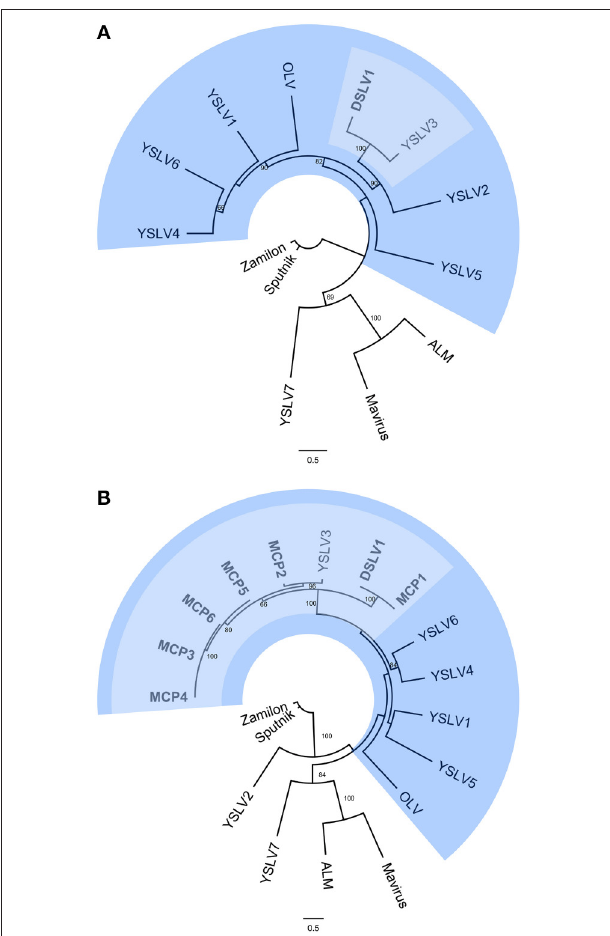
FIGURE 5 | Phylogenetic trees showing the relationship of DSLVs to other virophages. (A) A phylogenetic tree was reconstructed based on amino acid sequences of three conserved genes: MCP, Pro, and ATPase to compare DSLV1 to other known virophages. (B) Phylogenetic analysis of virophage MCP proteins, including all seven DSLV sequences identified in this study. Bootstrap values are indicated on each branch (100 iterations). DSLVs and YSLV3 are shaded in light blue. DSLVs and the closely related YSLVs and OLV are highlighted in blue. DSLVs are shown in bold. YSLV, Yellowstone Lake virophage; DSLV, Dishui Lake virophage; ALM, Ace Lake Mavirus; OLV, Organic Lake virophage. The accession numbers of the DSLV MCP gene sequences are as follows: KU245924 (MCP1), KU245925 (MCP2), KU245926 (MCP3), KU245927 (MCP4), KU245928 (MCP5), and KU245929